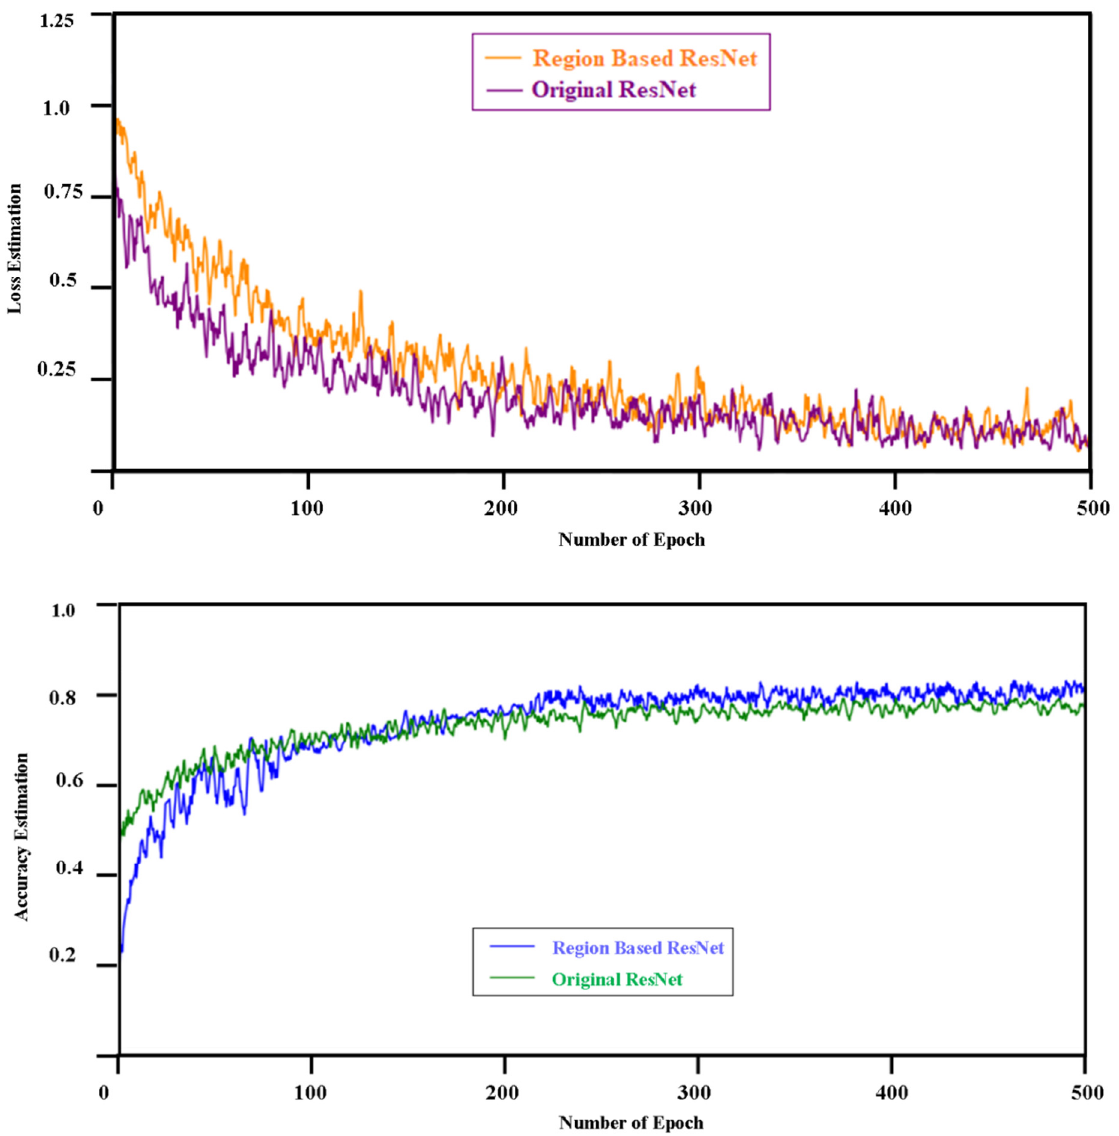
Figure 6. The training curve for the two classification models for estimation of loss and accuracy.